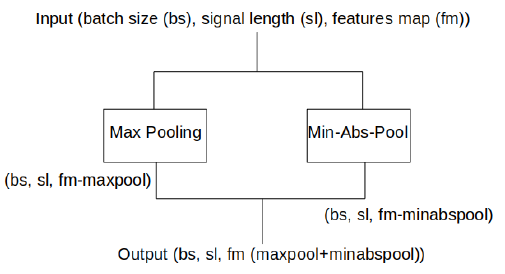
Figure 6. The above image represents a pooling block, which consists of the max pooling layer and the designed min-abs-pooling layer with concatenation of their outputs.